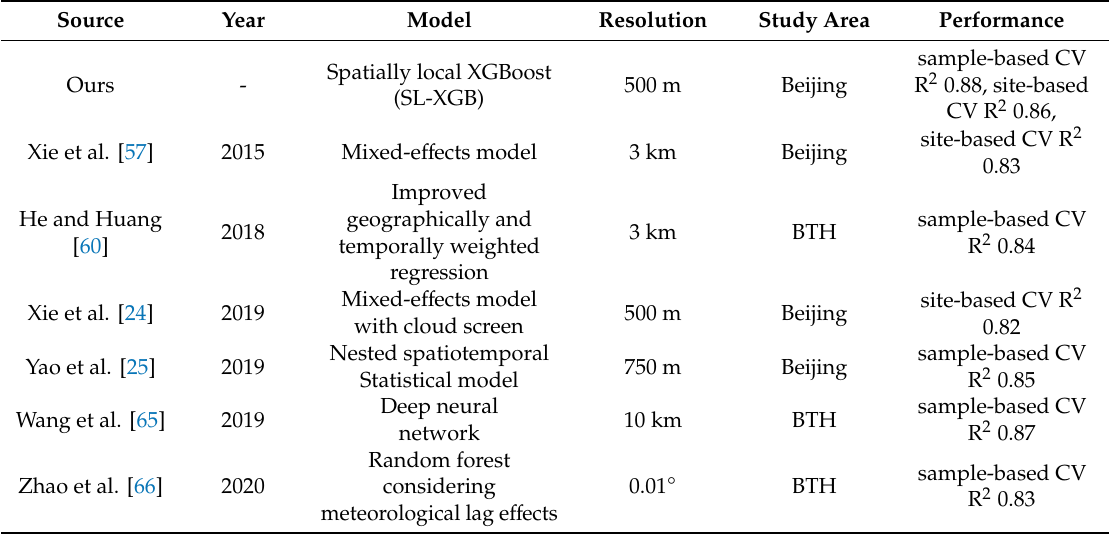
Table 3. Some comparisons of PM 2.5 estimation studies using Beijing or BTH as the study